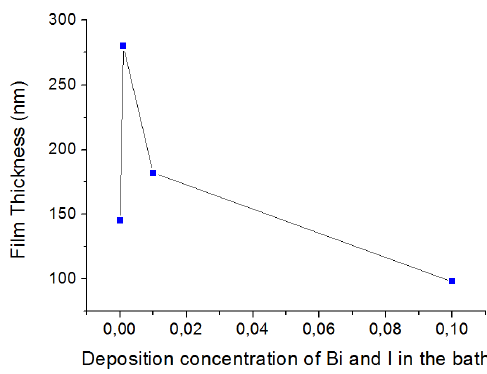
Fig. 3. Film thickness of the films.